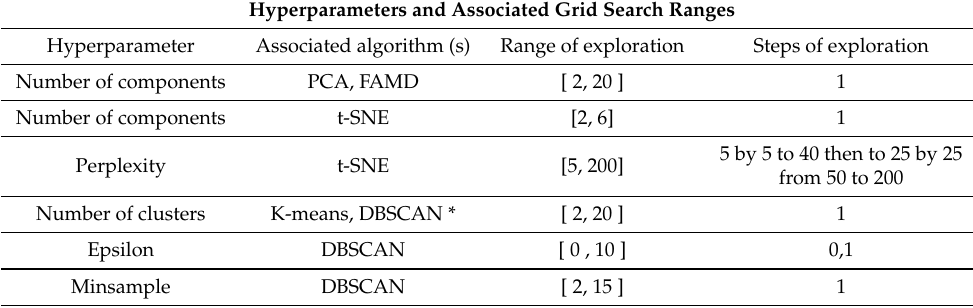
Table 5. Range of hyperparameters. Hyperparameters and Associated Grid Search